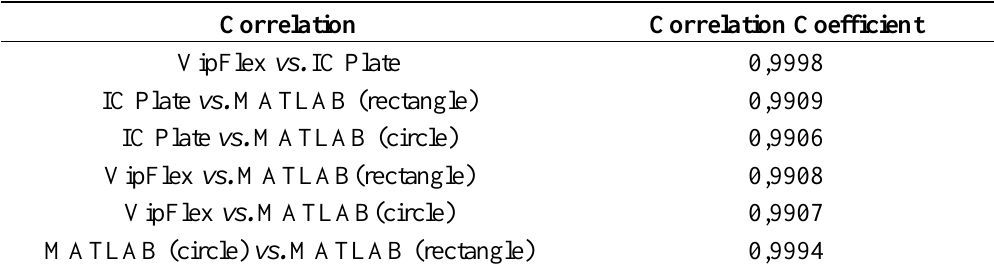
Table 1. Pearson correlation coefficient.